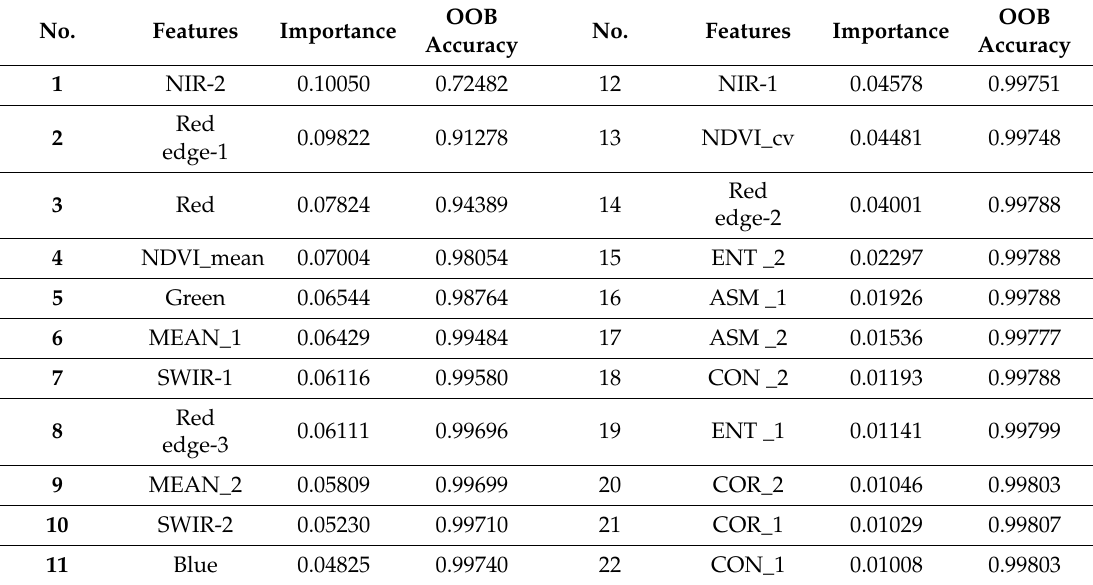
Table 1. Results of the feature importance measure.